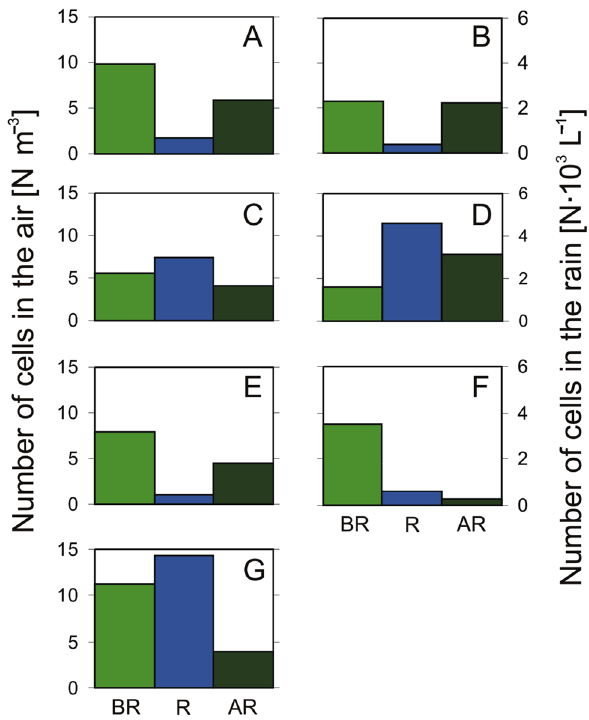
Figure 2. Number of microalgae and cyanobacteria cells in aerosol samples [cells m –3 ] before (BR) and after rainfall (AR) and in rain samples (R) [cells L –1 ] on the morning of August 25, 2020 ( A ), the afternoon of